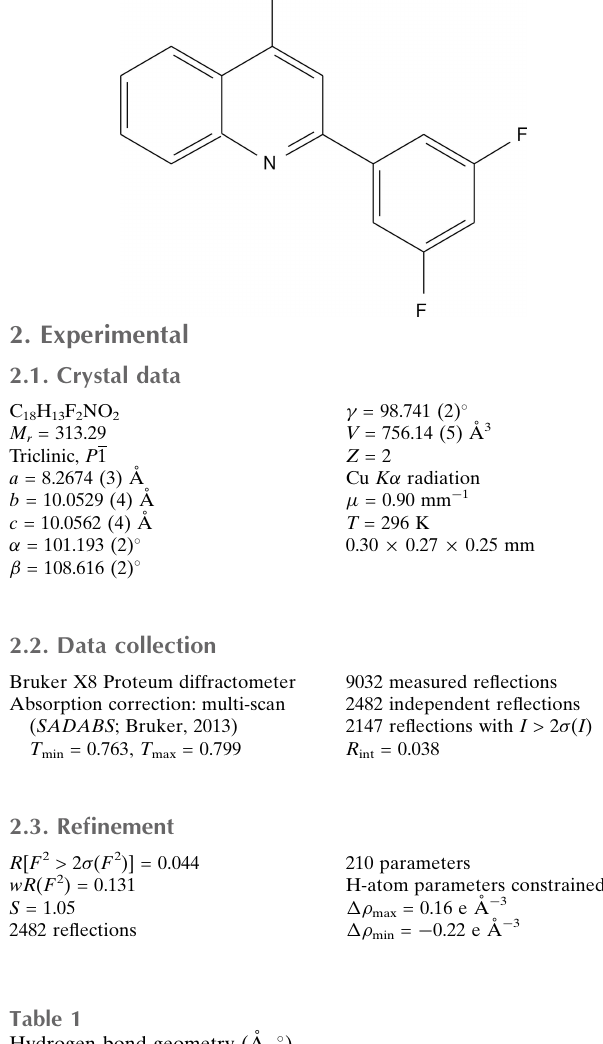
Hydrogen-bond geometry (A˚ , (cid:2)